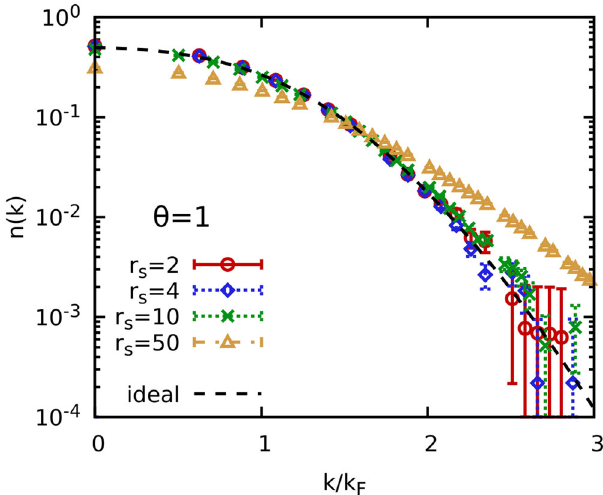
Fig. 5 Momentum distribution n ( k ) of the uniform electron gas at the electronic Fermi temperature θ = 1. The symbols show exact path integral Monte Carlo (PIMC) results for r s = 2 (red circles), r s = 4 (blue diamonds), r s = 10 (green crosses), and r s = 50 (yellow triangles); the dashed black line shows the Fermi distribution function describing a noninteracting Fermi gas. Taken from Dornheim et al. 50 , and reproduced with the permission of the American Physical